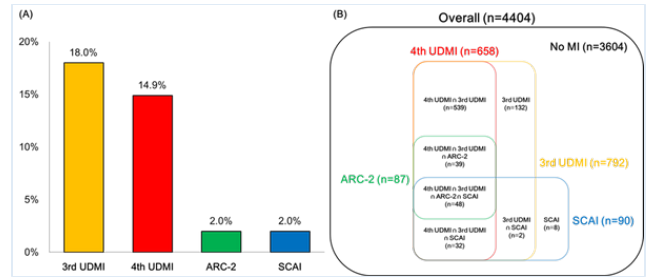
Figure 1. Frequency of peri-procedural myocardial infarction according to different